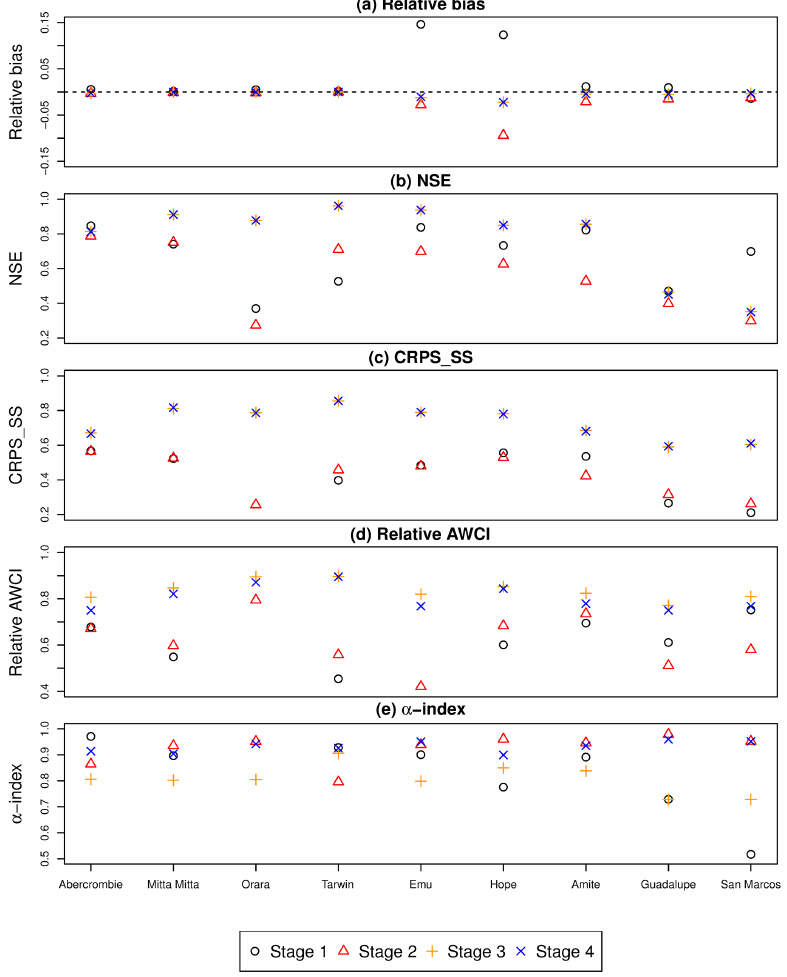
Figure 8. Same as Fig. 3 but the hydrological model is calibrated by the least-squares